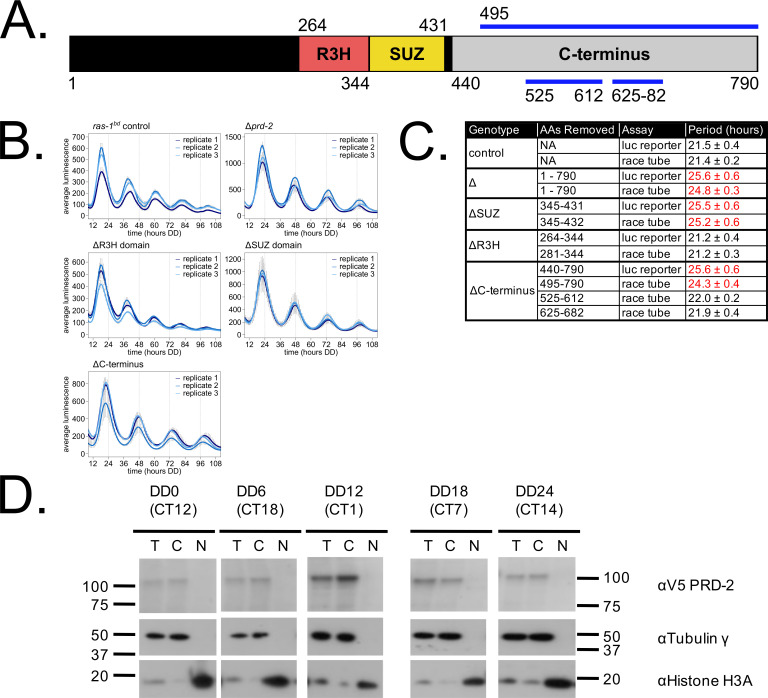
Clock-relevant protein domains and localization of PRD-2 suggest and RNA-binding function.PRD-2 has tandemly arrayed R3H and SUZ domains associated with RNA binding proteins, and its C-terminal region is highly enriched for proline (P) and glutamine (Q). The cartoon of PRD-2 protein lists relevant amino acid coordinates (A). The native NCU01019 locus was replaced with single domain deletion mutants, and 96-well plate luciferase assays were used to measure the circadian period length in triplicate wells per biological replicate experiment. A wild-type clock period was recovered in ras-1bd controls and the prd-2ΔR3H mutant, while Δprd-2, prd-2ΔSUZ, and prd-2ΔC-terminus had long period phenotypes (B). Independently constructed strains targeted domain deletion mutants to the csr-1 locus in a Δprd-2 background (Supplementary file 1), and mutant period lengths were determined by race tube assay. Period lengths (±1 SD) show that the clock-relevant domains of PRD-2 are the SUZ domain and the C-terminus (C). Total (T), Nuclear (N), and Cytosolic (C) fractions were prepared over a circadian time course (N = 1 per time point). γ-Tubulin (NCU03954) was used as a control for cytoplasmic localization and histone H3 (NCU01635) for nuclear localization. PRD-2 tagged with a C-terminal V5 epitope tag is localized to the cytoplasm throughout the circadian cycle (D).